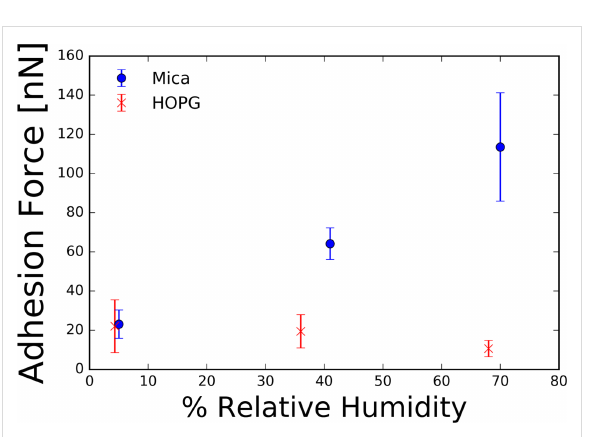
Figure 7: Average measured adhesion force on mica and HOPG sam- ples at various values of relative humidity. The hydrophilic mica shows an increasing adhesion force with increasing humidity while the hydro- phobic HOPG shows a nearly constant adhesion force as a function of relative humidity. Error bars represent one standard deviation from the